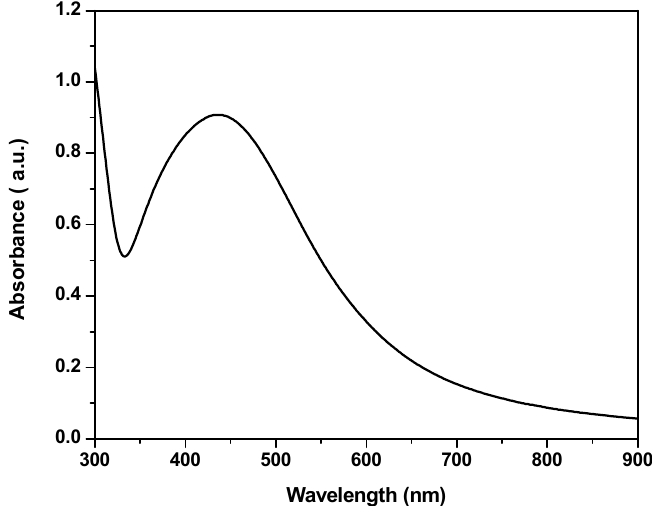
Figure 2. UV-visible spectra of fungal filtrate containing Ag